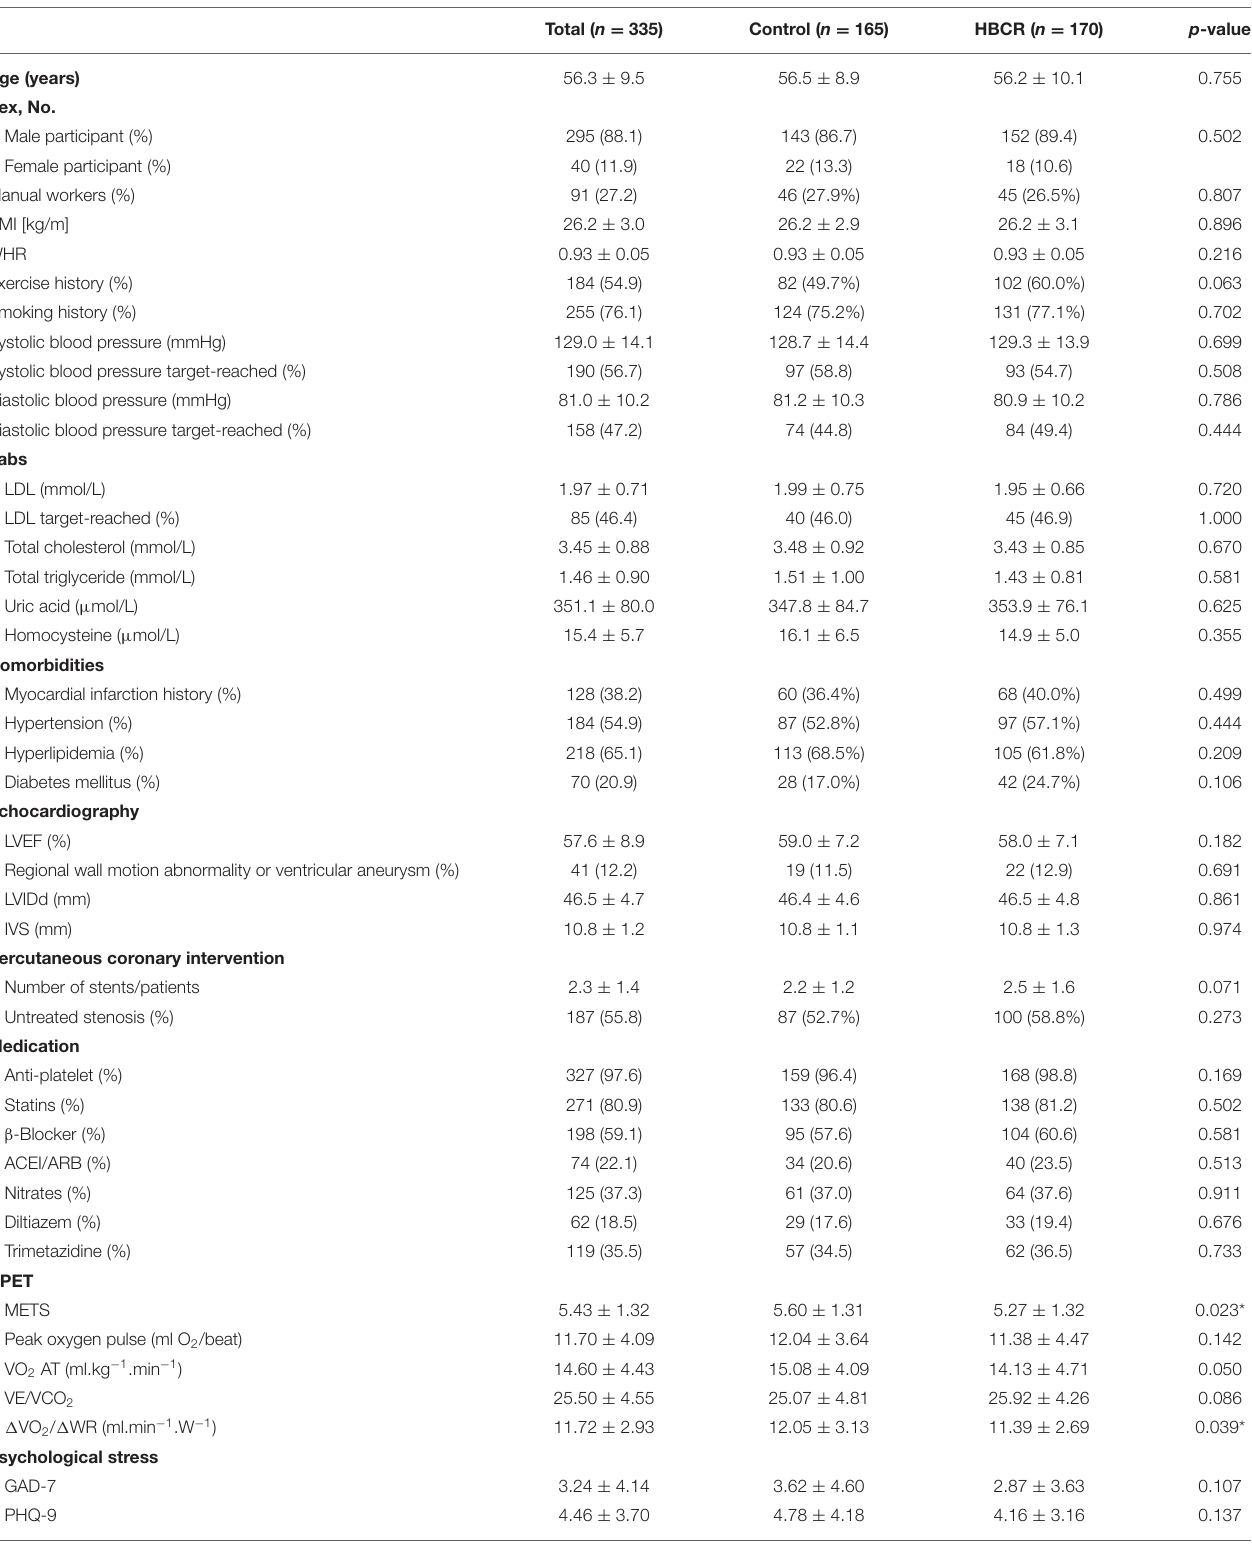
TABLE 1 | Patients’ baseline characteristics, by case and intervention